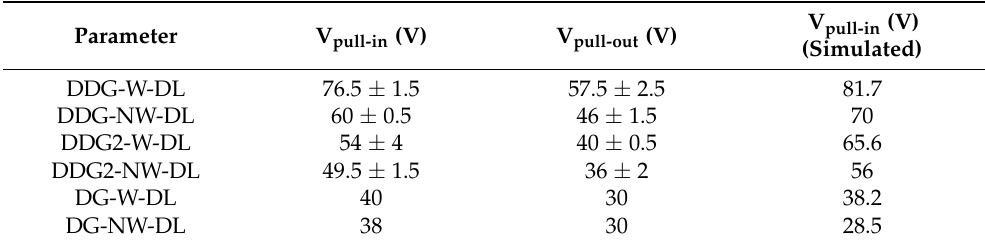
Table 4. Measured actuation (V pull-in ) and release (V pull-out ) voltages from Figure 11 and simulated actuation voltages.